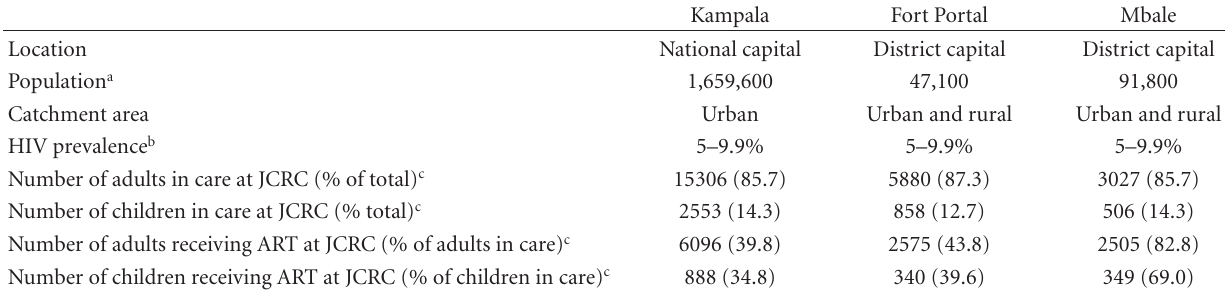
Table 1: Characteristics of the Joint Clinical Research Centre (JCRC)